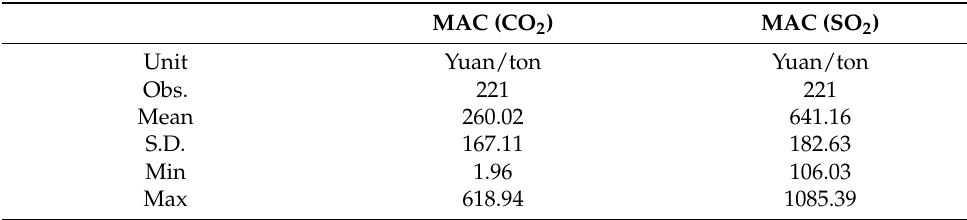
Table 3. Descriptive statistics of marginal abatement cost of CO 2 and SO 2